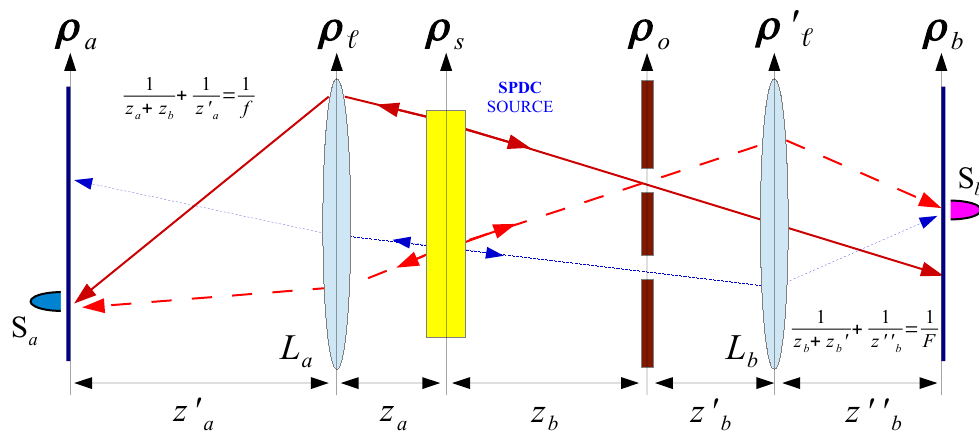
Figure 2. Unfolded version, or Klyshko picture, of the schematic setup reported in Figure 1, in the case in which the ghost image of the object is focused on the sensor S a . On one hand, by means of coincidence detection, the lens L a reproduces on the sensor S a the ghost image of the object. On the other hand, the source and the sensor S b are in conjugate planes of the lens L b . However, based on the advanced-wave model proposed by Klyshko, the effect can be understood by treating sensor S b as the light source and the SPDC source as a simple mirror. The solid and the dashed lines represent two-photon amplitudes that pass through the same slit; hence, at second order, they are focused in the same point of sensor S a . The dashed and the dotted two-photon amplitudes are emitted by the same source point and are thus focused in the same point of sensor S b